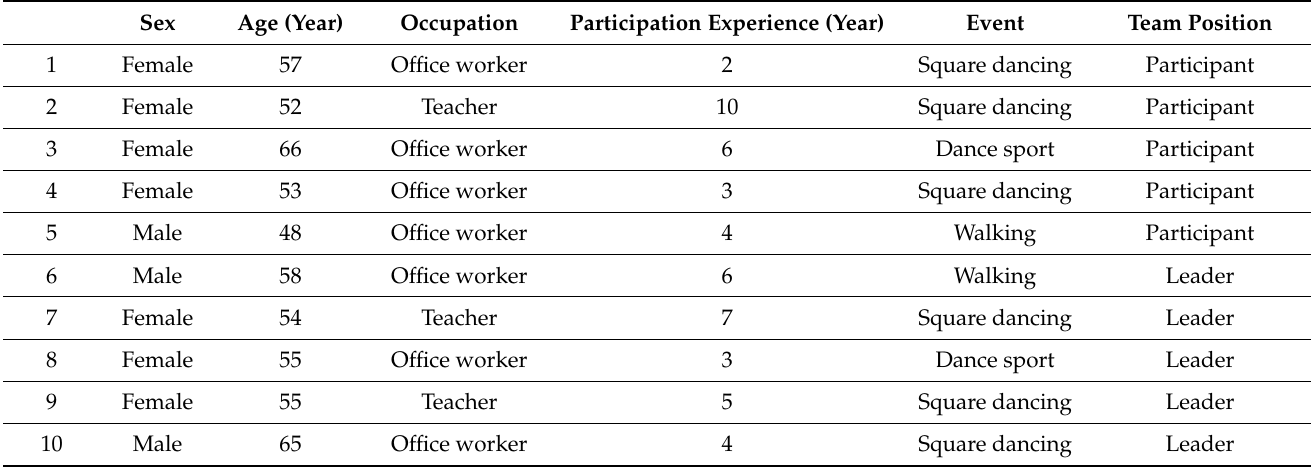
Table 1. Study participants’